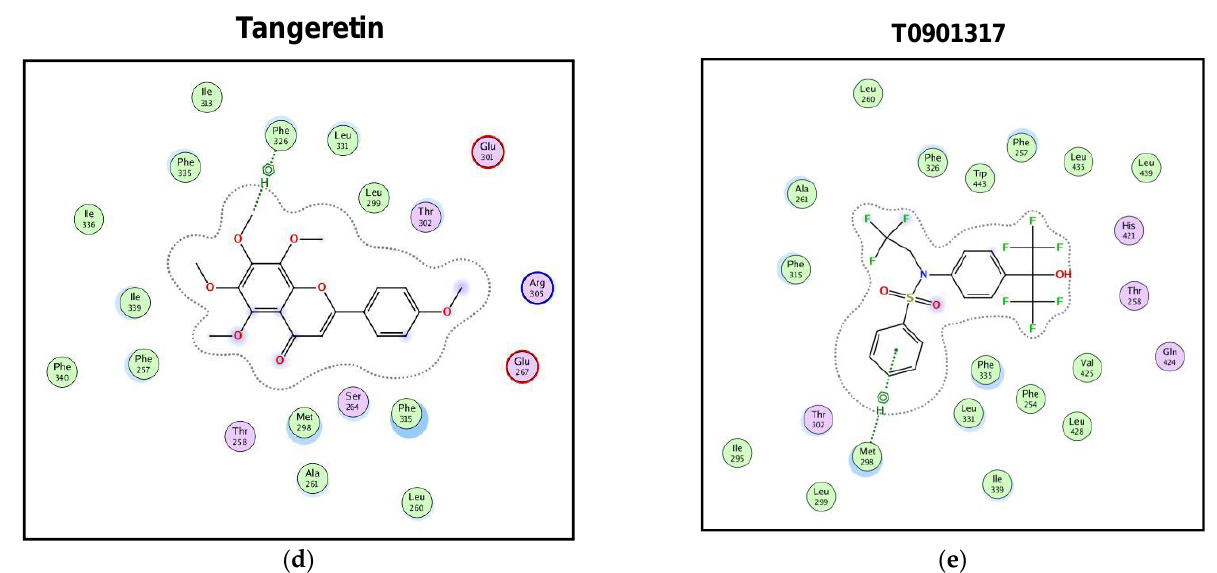
Figure 9. Tangeretin can dock into the ligand-binding domain of LXRα. The poses of tangeretin and T0901317 docked preferentially to the ligand-binding domain of LXRα. LXRα is shown as a gray ribbon, and the compounds are shown in ( a ) red (tangeretin) and ( b ) blue (T0901317). ( c ) The superposition of both tangeretin and T0901317 docked to the ligand-binding pocket of LXRα. Two-dimensional interaction map of LXRα with ( d ) tangeretin and ( e ) T0901317. The hydrophobic and hydrophilic amino acid residues near the compounds are colored green and pink, respectively.